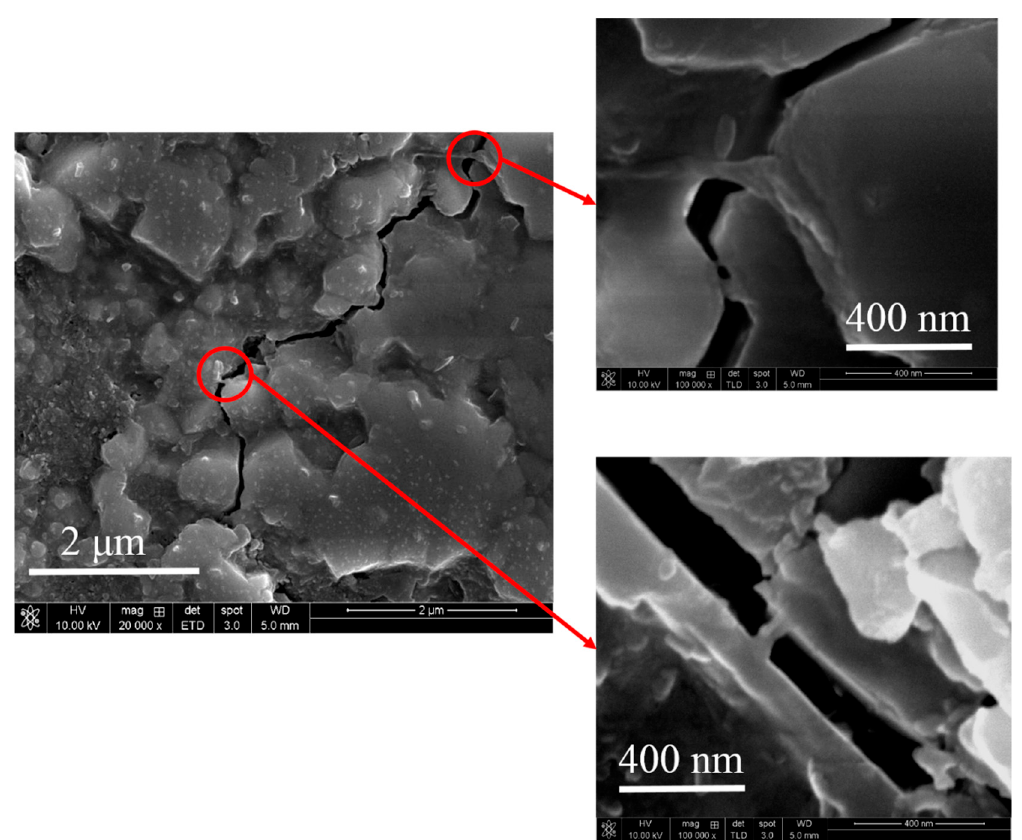
Figure 4. SEM micrograph of sintered 1 wt.% r-GO/HA showing the presence of r-GO for bridging the cracks.